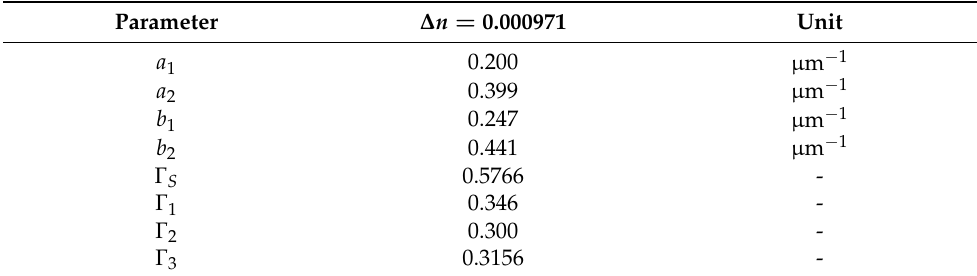
Table 2. Parameters used in fitting functions for circular waveguides. Here, the cladding refractive index is n 2 = 3.4 and the core refractive index is n 1 = n 2 + ∆ n